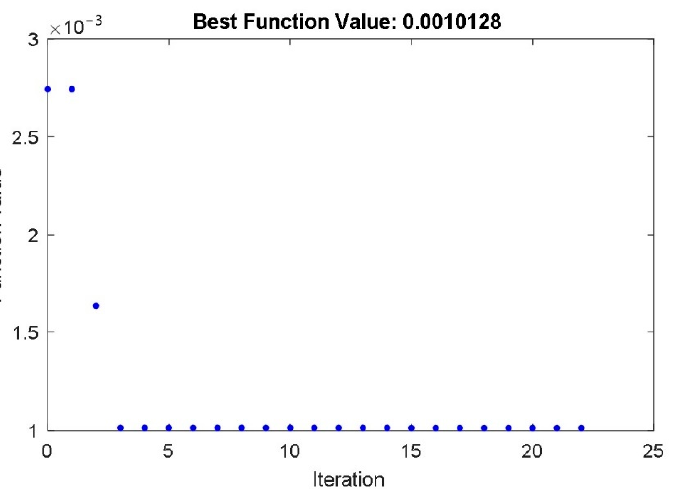
Figure 11. The time course of the IAE objective function during the PSO with the parameters k μ m , k α , and T ϑ cs .